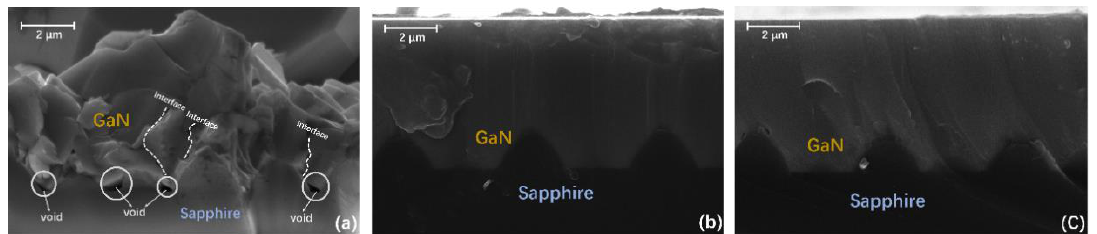
Figure 5. The cross-sectional SEM images of GaN films on ( a ) 10 nm, ( b ) 25 nm, and ( c ) 40 nm sputtered AlON/PSS templates.